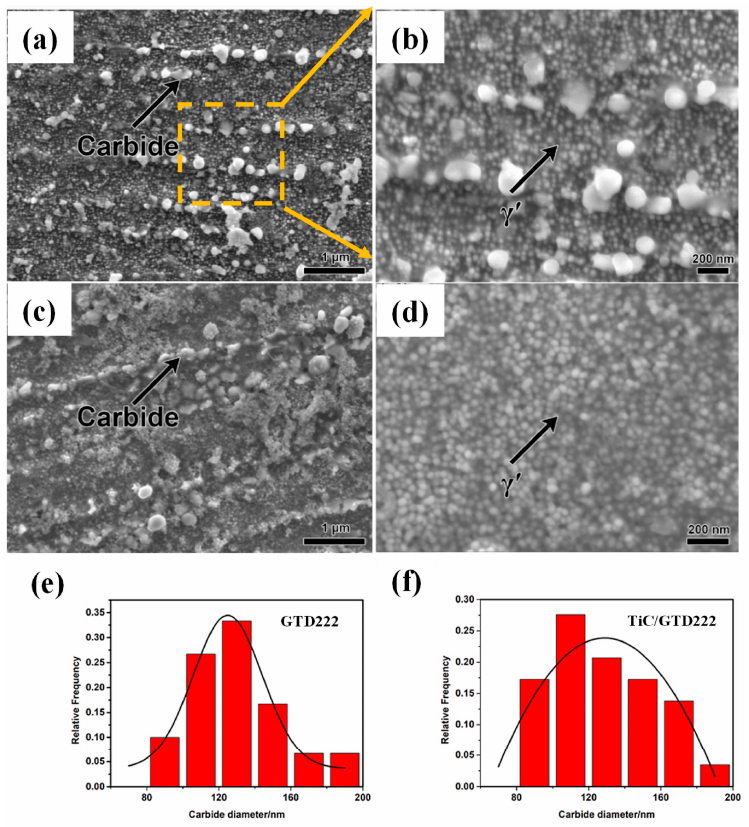
Figure 15. SEM images and corresponding to carbide particle size distributions after heat treatment: ( a ) GTD222, ( b ) Enlarged image of square area in Figure 14a, ( c ) TiC/GTD222 composite, ( d ) TiC/GTD222 local area magnification, ( e ) Carbide particle sizes distribution in GTD222, ( f ) Carbide particle sizes distribution in TiC/GTD222 composite [5].